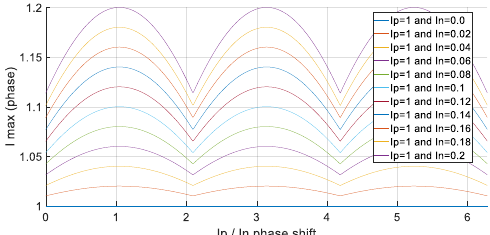
Figure 5. Maximum current out of the three phases for a 1 pu positive sequence current and a negative sequence current from zero to 0.2 pu (0.02 pu steps). Θ = 0, and β = 0–2 π